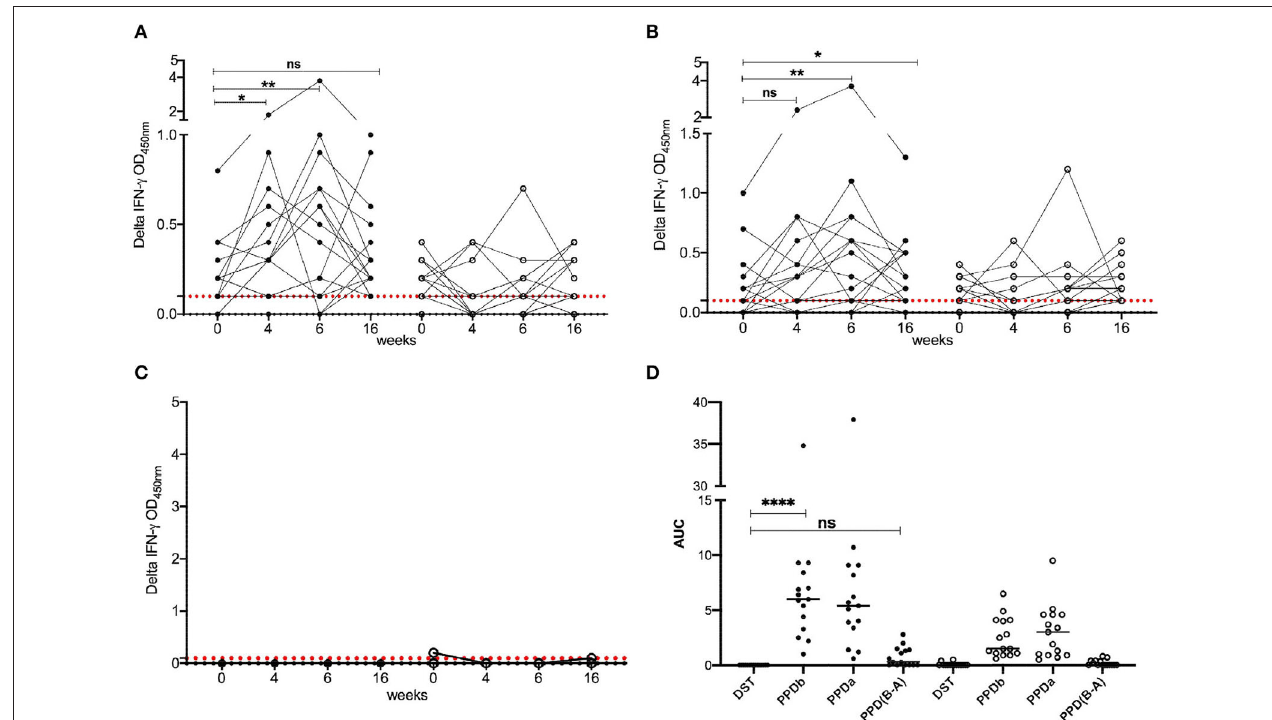
FIGURE 2 | IFN- γ responses following BCG vaccination. Responses of BCG vaccinates (closed circle, n = 15) and controls (open circle, n = 15) to (A) PPD-B, (B) PPD-A, and (C) DST. The background-corrected (delta) optical density (OD) values are plotted. Time is shown as weeks post-vaccination in the x -axis. Calves were vaccinated with BCG at week 0. Blood was collected for IGRA just prior to injection of BCG, and at weeks 4, 6, and 16 post-vaccination. Skin test using PPDs and DST was conducted at weeks 6 and 16. The pairwise difference between pre- and post-vaccination time points was determined using the Wilcoxon matched pairs signed rank test (** P < 0.01; * P < 0.05). The dotted red line represents the IGRA cutoff of 0.1. (D) The bottom right panel provides the area under the curves (21), where the horizontal line provides the median, and the statistical difference between the responses was determined using Friedman (non-parametric) test (**** P <